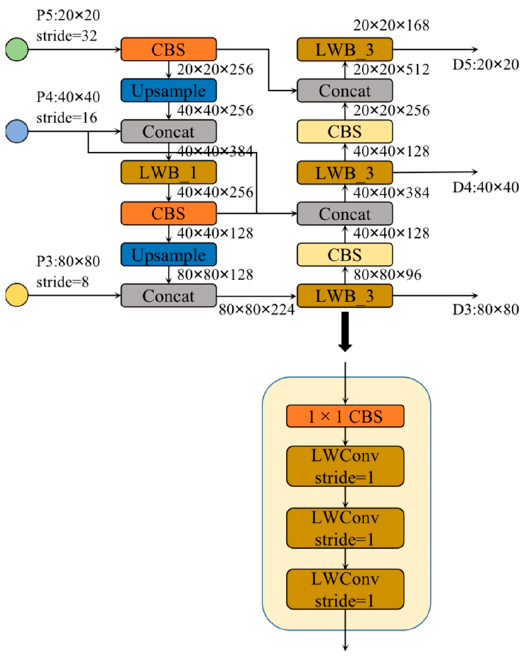
Figure 9. The overview of e ffi cient feature fusion network.